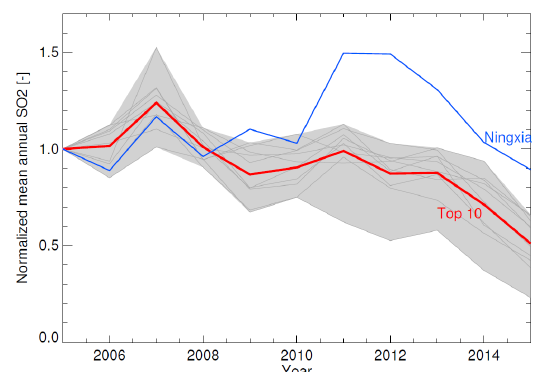
Figure 4. Time series (red line) of the annual mean of the 10 provinces with the highest SO 2 concentrations derived from the OMI satellite observations. The time series are normalized to their value in 2005. The grey area indicates the maximum range of the in- dividual values of the times series of each of the 10 provinces. The thin grey lines show the individual time series of those provinces. The province of Ningxia has a distinct deviating trend, here shown in